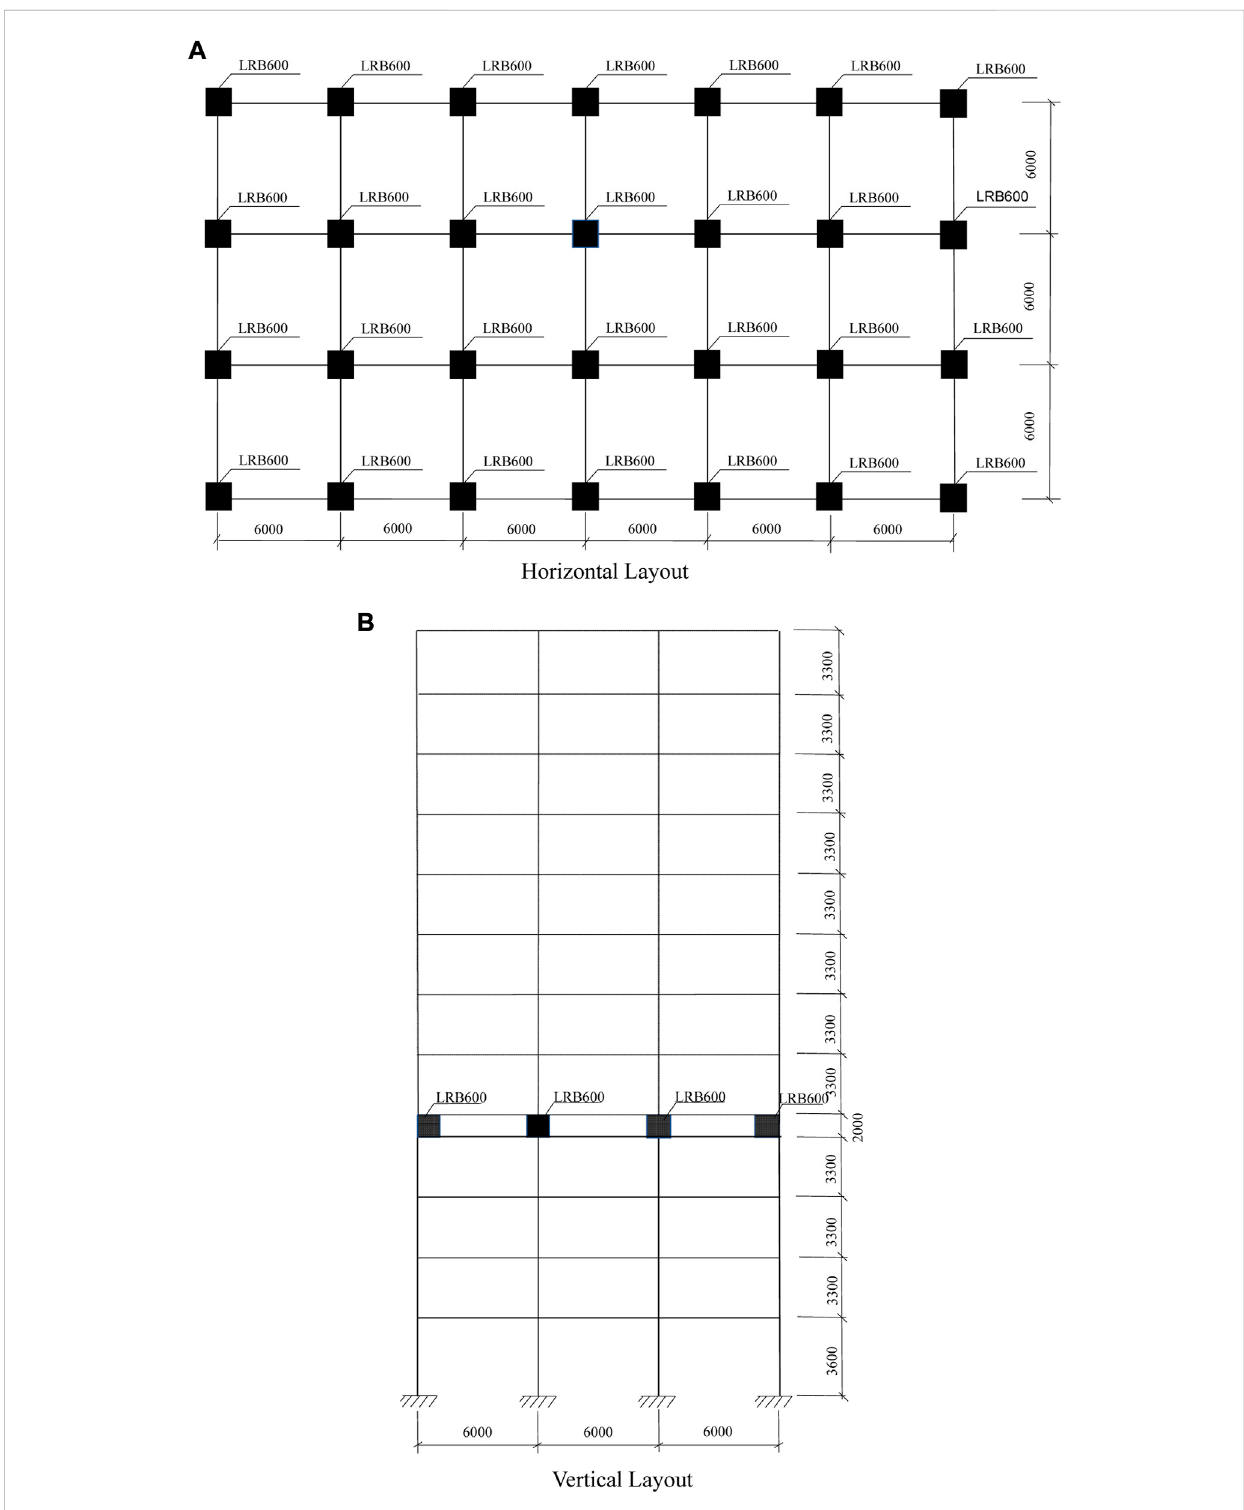
tensile strength, f t = 1.43 N/mm 2 ; and HRB400 steel, with an elastic modulus, E 0 , of 2 × 10 5 N/mm 2 , and yield strength, f y = 360 N/mm 2 . The isolation layer was set at the top of the